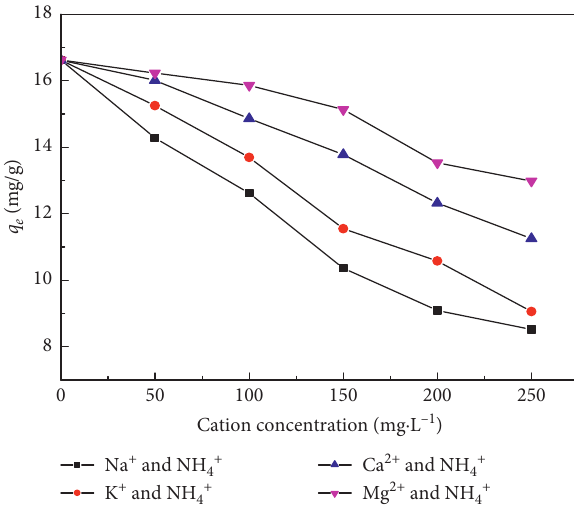
Figure 8: Effect of anions concentration on ammonium adsorption (EMRZ dosage � 0.2g/100mL; contact time � 100min; pH val- ue � 8.0; initial ammonium concentration � 100mg/L; temperature � 25 °